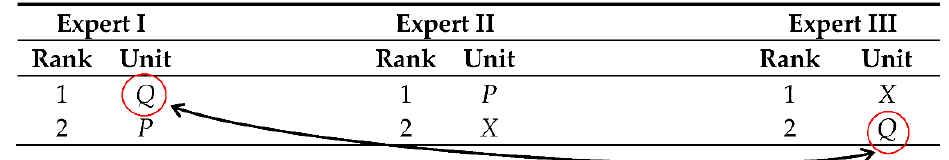
Figure 4. Indirect contradiction among Experts I, II, and III.